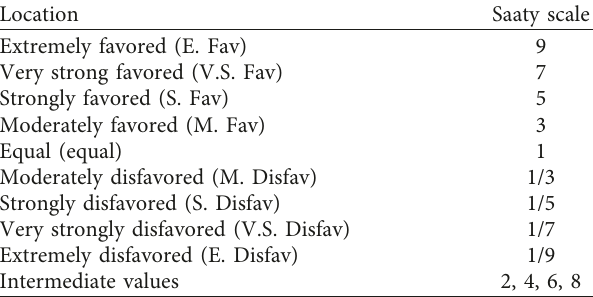
Table 1: Traditional AHP numerical scale.